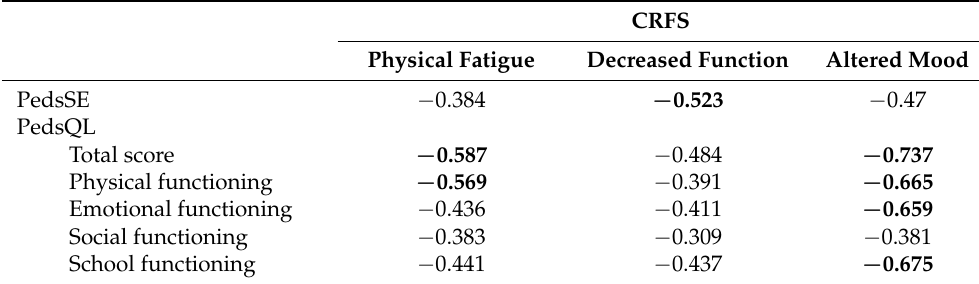
Table 3. Correlations between each subscale of the CRFS and PedsSE or the PedsQL subscales in childhood cancer survivors ( n = 46). CRFS Physical Fatigue Decreased Function Altered Mood PedsSE − 0.384 − 0.523 − 0.47 PedsQL Total score − 0.587 − 0.484 − 0.737 Physical functioning − 0.569 − 0.391 − 0.665 Emotional functioning − 0.436 − 0.411 − 0.659 Social functioning − 0.383 − 0.309 − 0.381 School functioning − 0.441 − 0.437 −